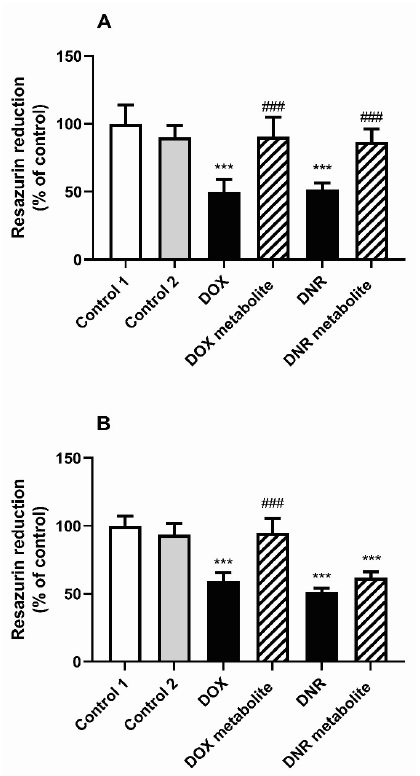
Figure A2. The effect of conditioned media on the resazurin redution after 24 h ( A ), and 48 h ( B ) in BJ fibroblasts: *** p < 0.001 versus the control 1 cultures. ### p < 0.001 versus the cell espoused to medium before conditioning. Control 1—cell culture medium with PBS, Control 2—cell culture medium with Park Robinson medium for fungi culture, DOX—cell culture medium with doxorubicin, DOX metabolite—cell culture medium with doxorubicin after fungi culture, DNR—cell culture medium with daunomycin, DNR metabolite—cell culture medium with daunomycin after fungi culture.